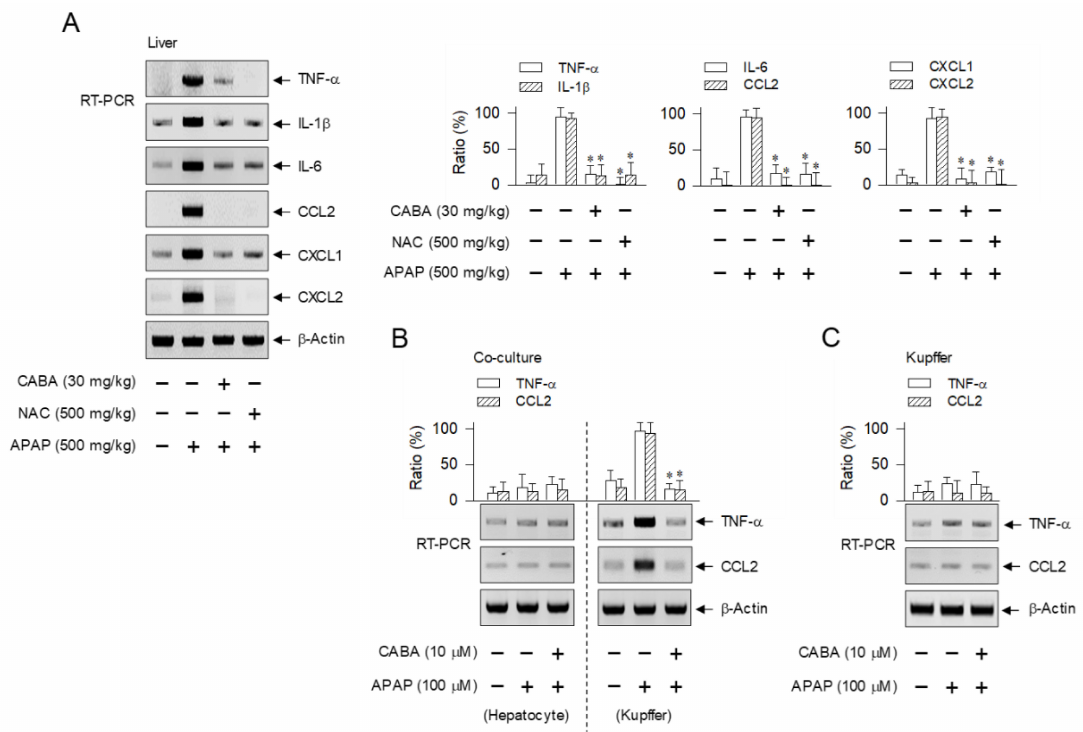
Figure 6. Effect of CABA on the expression of cytokine or chemokine. ( A ) C57BL/6 mice were treated with CABA at 1 h after APAP overdose. Liver lobules were biopsied at 15 h. Total RNAs were subjected to RT-PCR analysis of TNF- α , IL-1 β , IL-6, CCL2, CXCL1, or CXCL2 with internal control β -actin. ( B ) Co-culture of hepatocytes and Kupffer cells or ( C ) monoculture of Kupffer cells was pretreated with CABA for 2 h and stimulated with APAP for 12 h in the presence of CABA. Total RNAs were subjected to RT-PCR analysis of TNF- α or CCL2 with internal control β -actin. Ratio (%) represents relative intensity of signals in RT-PCR analysis. * p < 0.05 vs. APAP